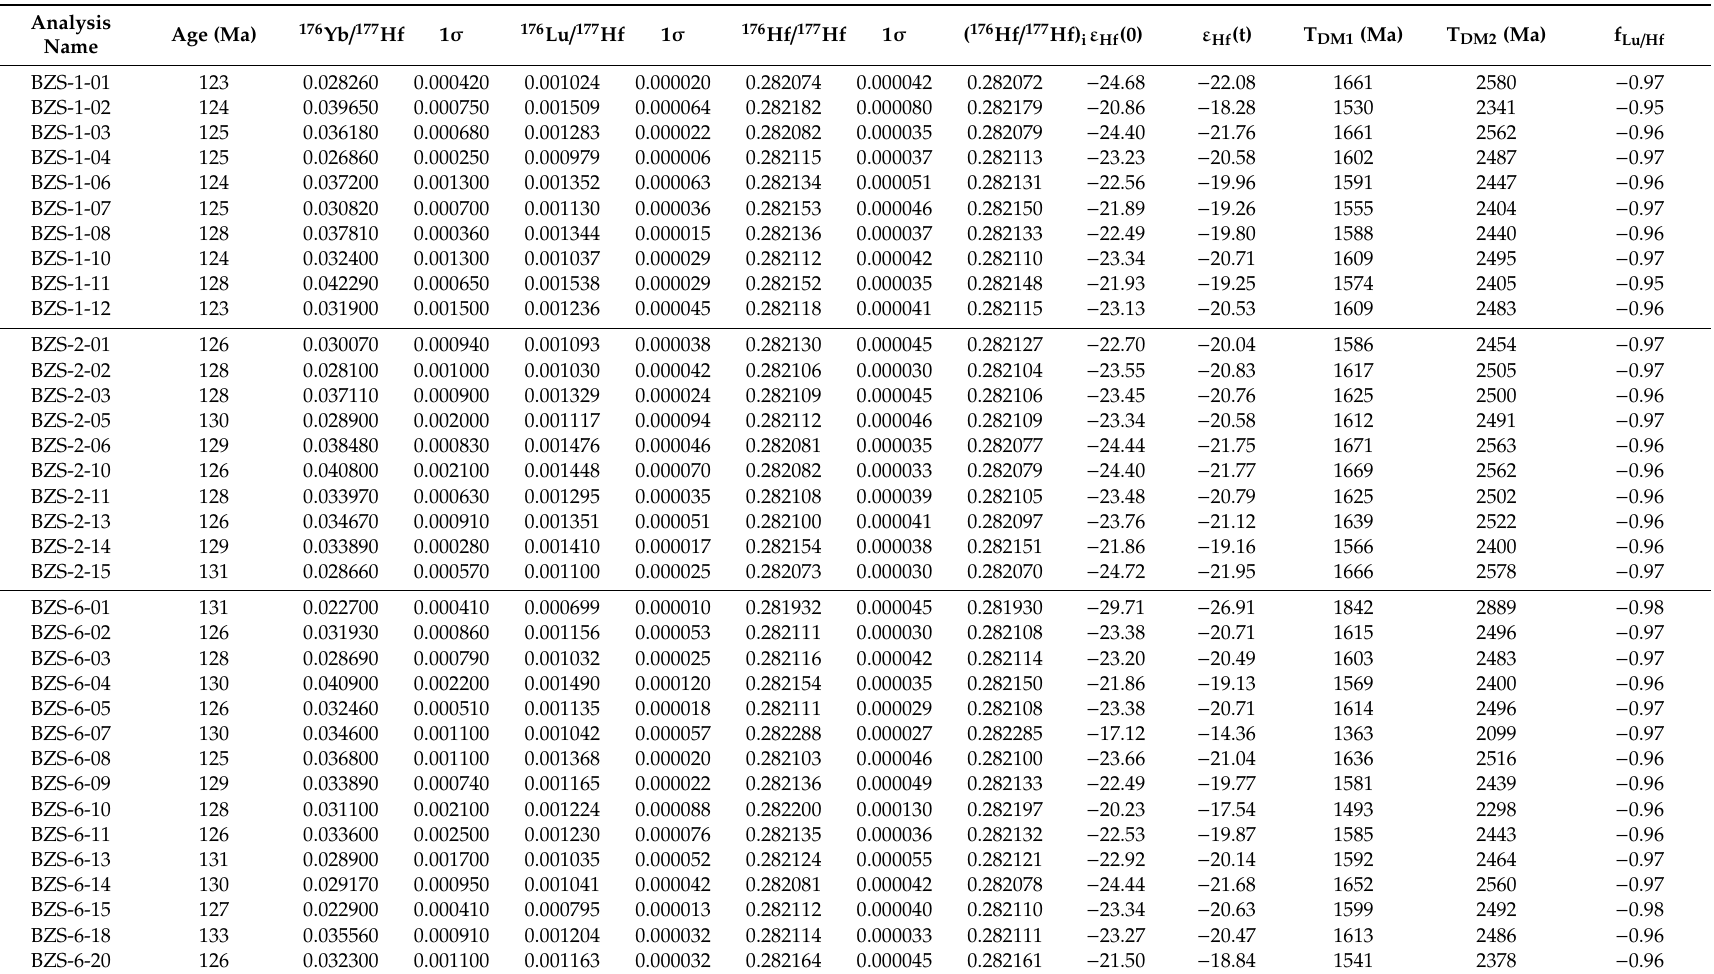
Table 3. In situ La-MC-ICP-MS zircon Hf isotope compositions for the Banzhusi granite